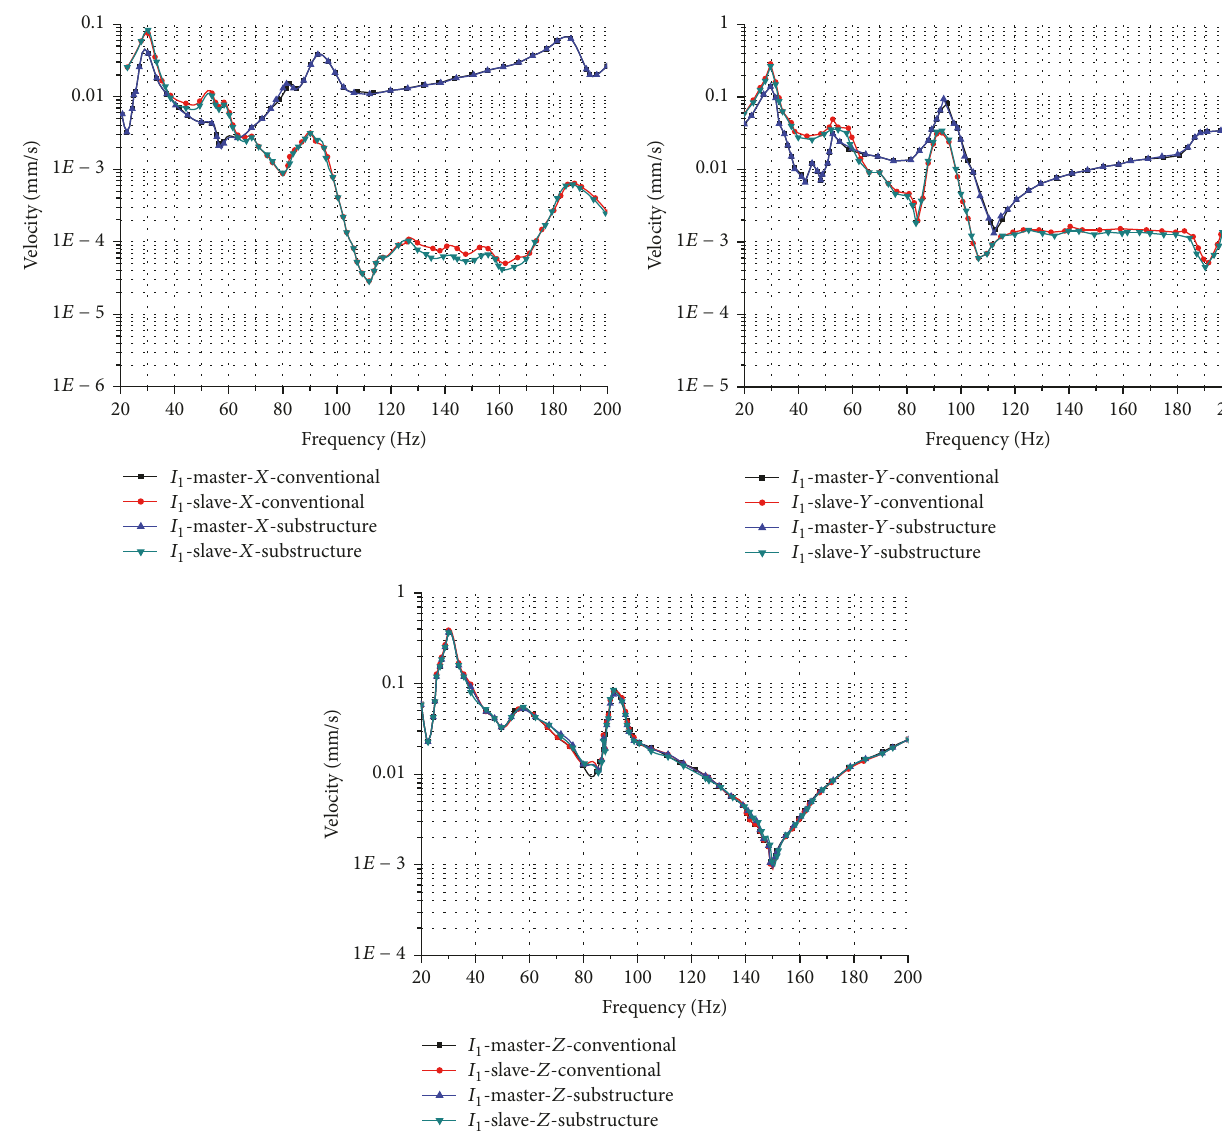
Figure 4: Velocity characteristic of 𝐼 1